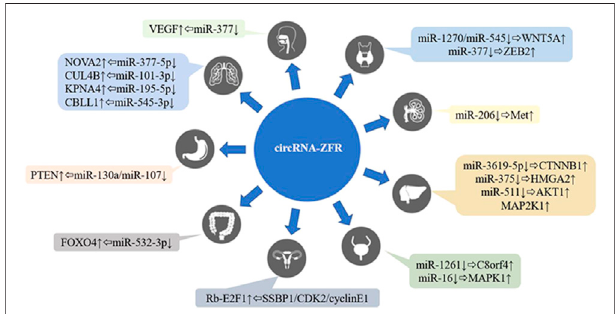
FIGURE 2 | The regulatory network of circRNA-ZFR on human malignant tumors. HIF1A, hypoxia-inducible factor 1 α ; C8orf4, transcriptional and immune responseregulator; MAPK1, mitogen-activated protein kinase 1; Met, met proto-oncogene; WNT5A, Wnt family member 5A; ZEB2, zinc fi nger E-box binding homeobox 2; E2F1, E2F transcription factor 1; VEGF, vascular endothelial growth factor; HMGA2, high mobility group AT-hook 2; CTNNB1, catenin beta 1; AKT1, AKT serine/threonine kinase 1; MAP2K1, mitogen-activated protein kinase kinase 1; NOVA2, NOVA alternative splicing regulator 2; CUL4B, cullin 4B; KPNA4, karyopherin subunit alpha 4; CBLL1, Cbl proto-oncogene like 1; PTEN, phosphatase and tensin homolog; FOXO4, forkhead box